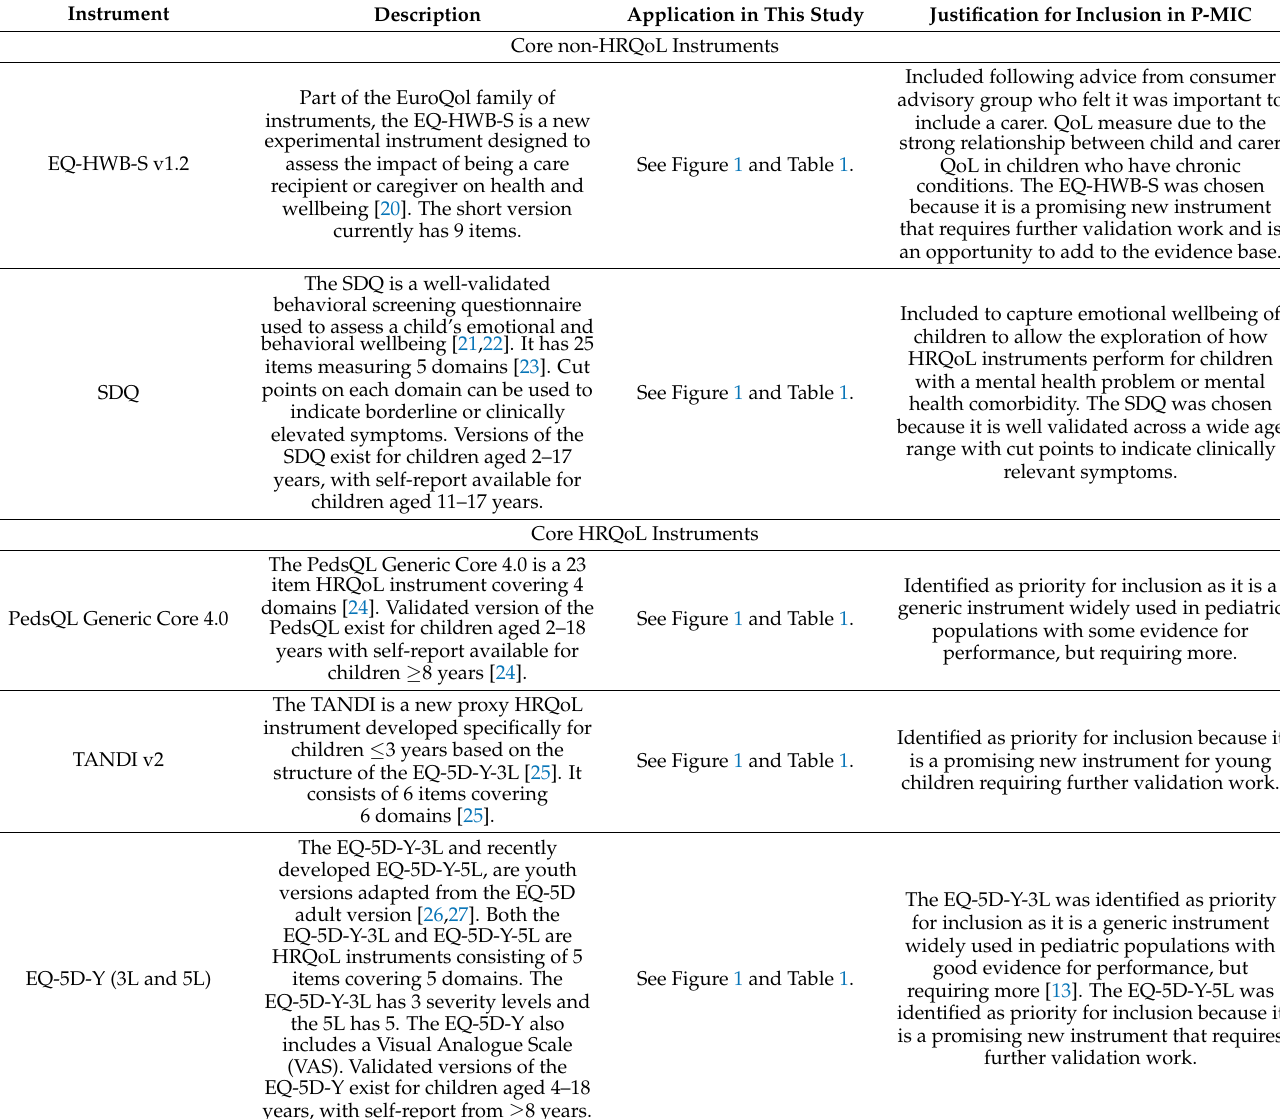
Table A1. Overview of instruments with justification for inclusion in